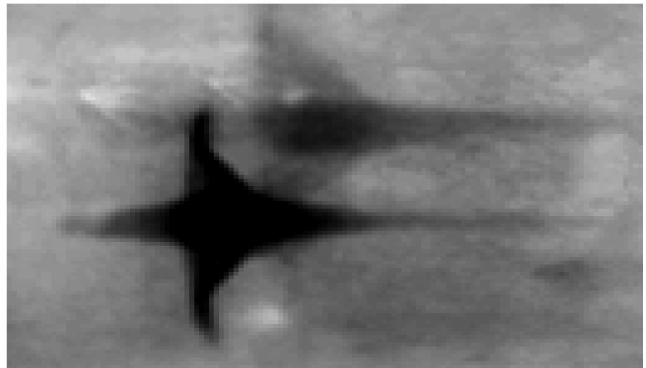
Figure 5. X-ray results of the high-density reactive jet